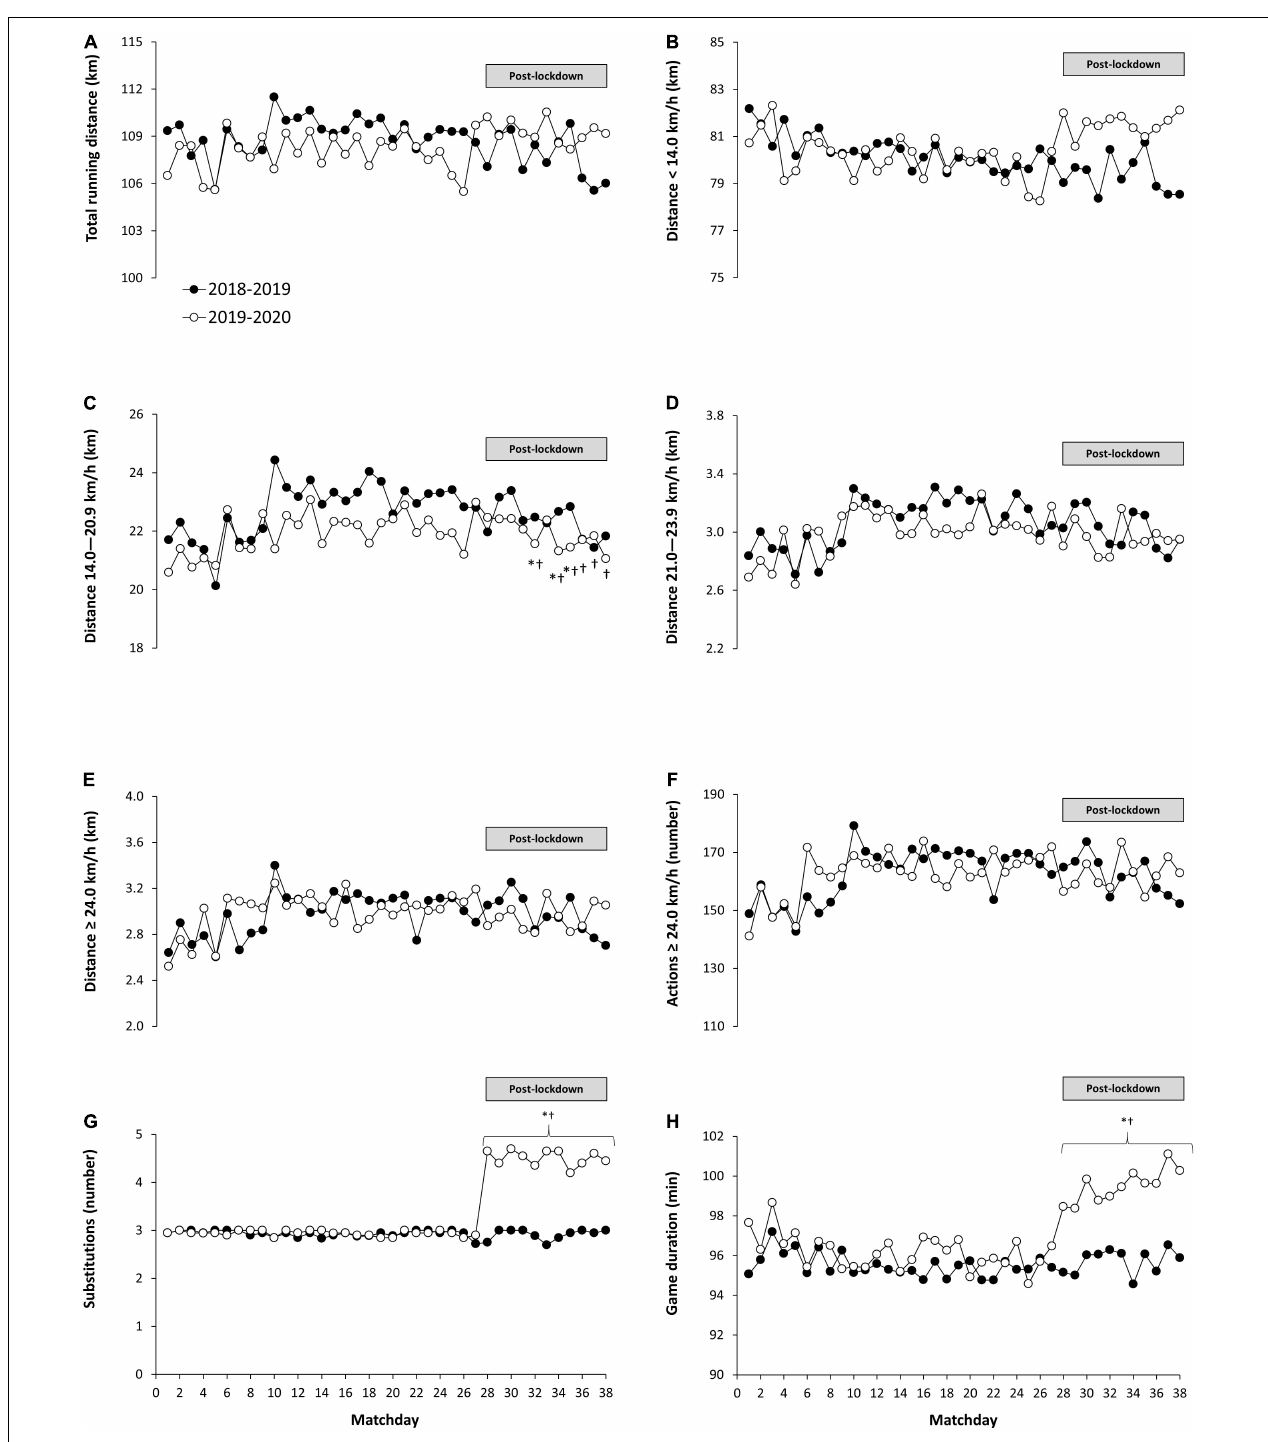
FIGURE 1 | Total running distance per match, distance at different speed thresholds, number of sprints, players’ substitutions, and game duration in LaLiga in the 2018–2019 and 2019–2020 seasons. (A) Total running distance, (B) running distance covered at < 14.0 km/h, (C) running distance covered between 14.0 and 20.9 km/h, (D) running distance covered between 21.0 and 23.9 km/h, (E) running distance covered at ≥ 24.0 km/h, (F) number of sprints covered at ≥ 24 km/h, (G) number of players’ substitutions, (H) game duration. Each dot represents mean value for 20 teams on each matchday for each season (*) Different from the same matchday in the 2018–2019 season, P < 0.05. ( † ) Different from matchday 27 in the 2019–2020 season, P < 0.05. Note: In the 2019–2020 season, the competition was suspended after matchday 27 due to the COVID-19 pandemic. The competition was resumed after 12 weeks (8 weeks of lockdown and 4 weeks of retraining) to complete the 38 matchdays that comprised